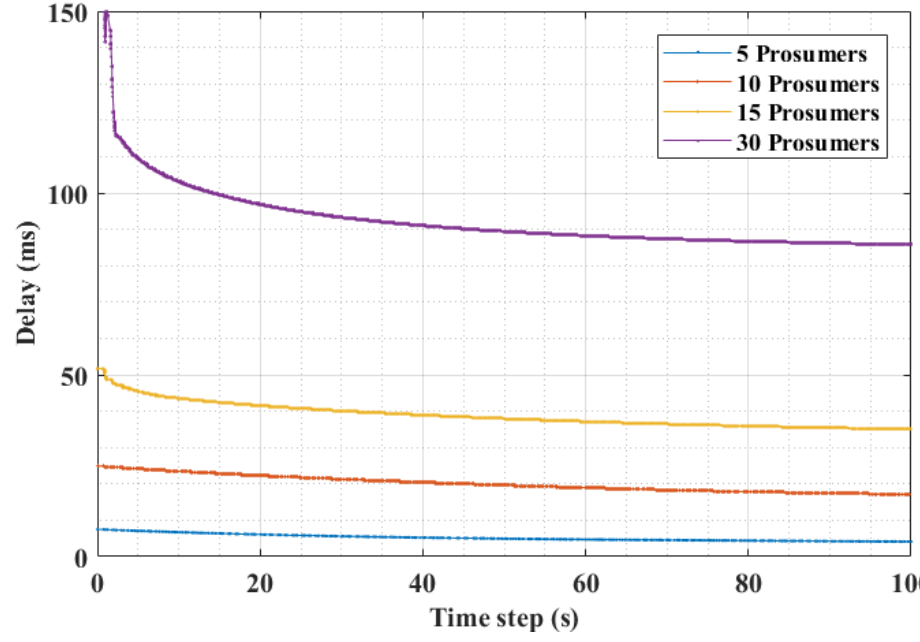
Figure 10. Delay cost function for different number of